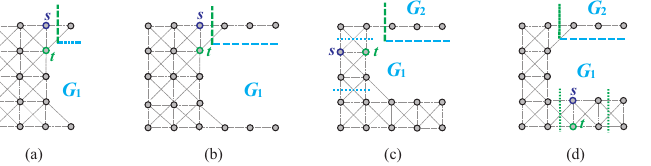
Figure 22. The cases for s , t ∈ G 1 and { s , t } is a vertex cut of G 1 , where ( a , b ) { s , t } = { ( a ,1 ) , ( a ,2 ) }